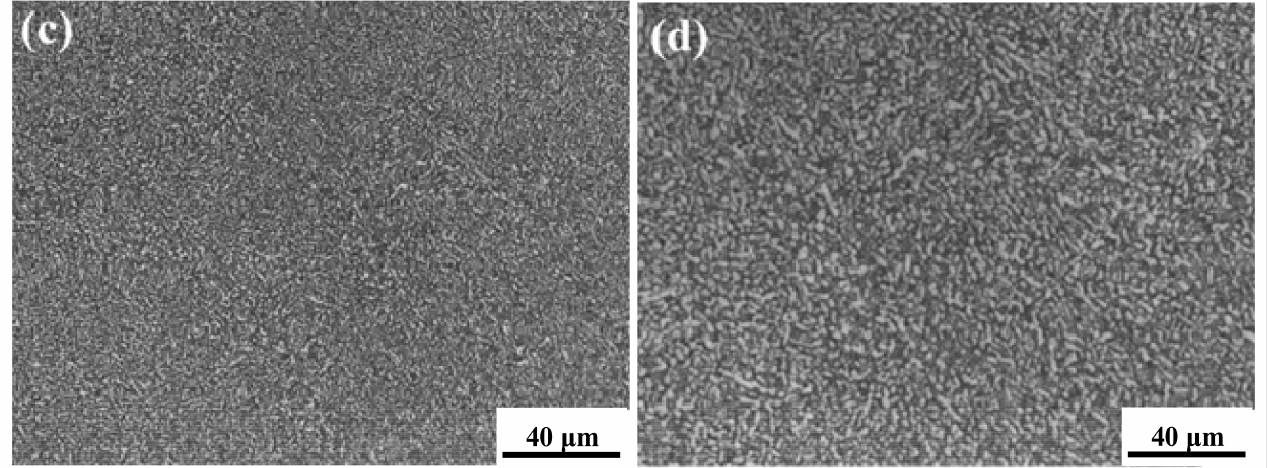
Figure 2. Optical images of the forged ( a ) SP700Cr, ( c ) SP700Cr alloy after AC710, ( e ) SP700Cr alloy after AC800 and ( g ) SP700Cr alloy after AC820 +